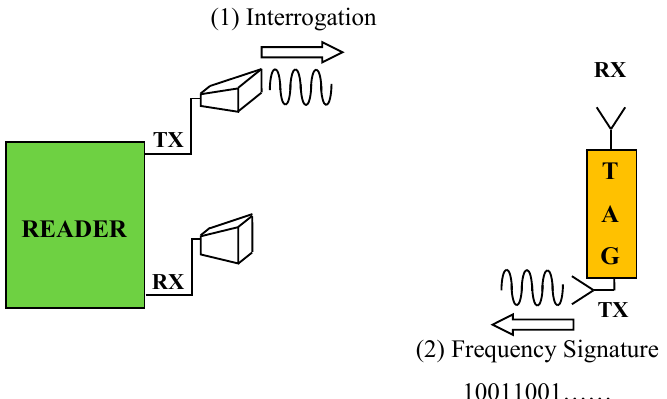
Figure 1. Schematic representation of a generic multi-resonator chipless tag Radio Frequency Identification (RFID) system [19].